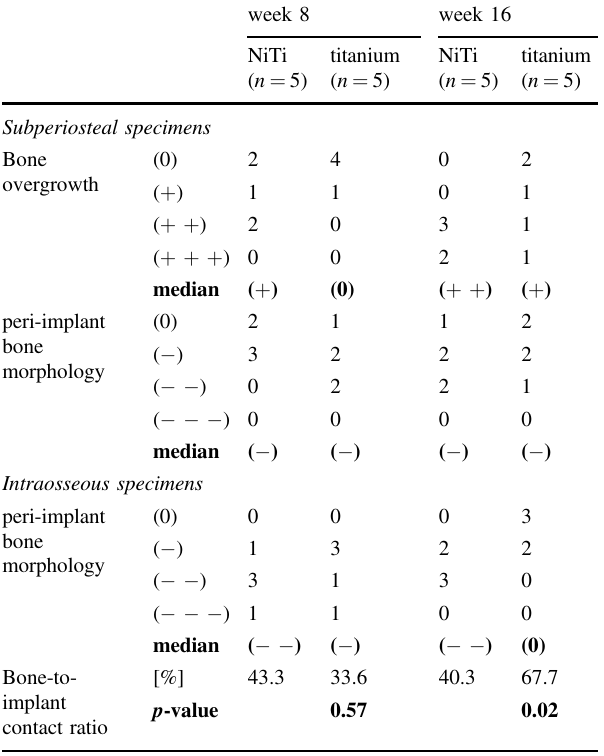
Table 1 Histomorphometric evaluation of the peri-implant bone